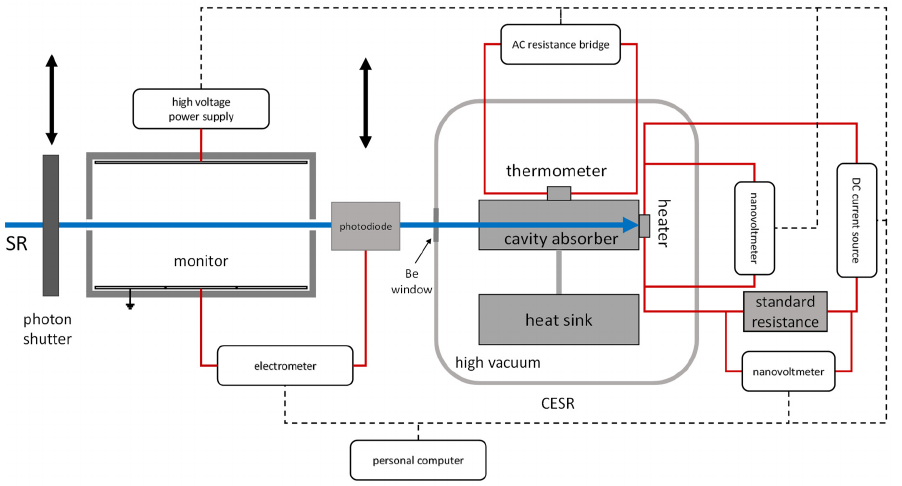
Figure 8. Schematics of the absolute radiant power measurement and calibration system using the CESR. Red solid lines indicate measurement signal and supply cables, and dashed lines indicate control signal